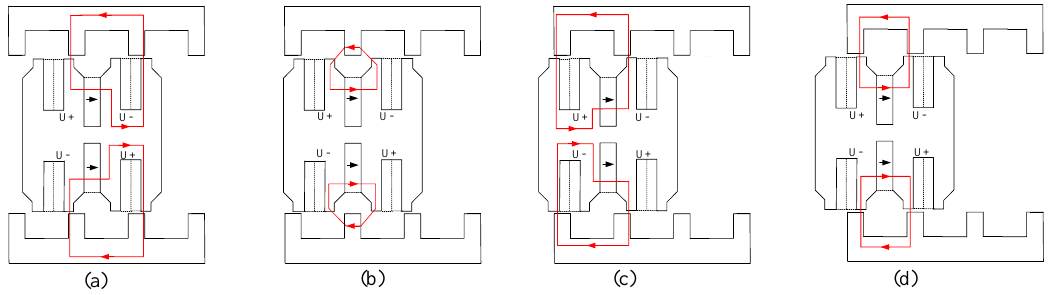
Figure 4. Operating principle of DSLFSPMM: ( a ) θe = 0°; ( b ) θe = 90°; ( c ) θe = 180°; ( d ) θe = 270°.